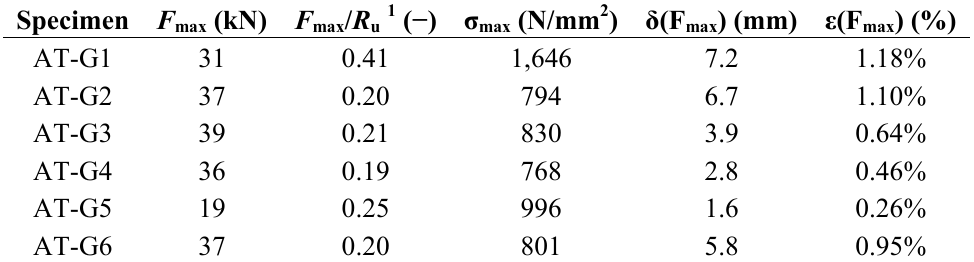
Table 9. Test results of Series AT-G.